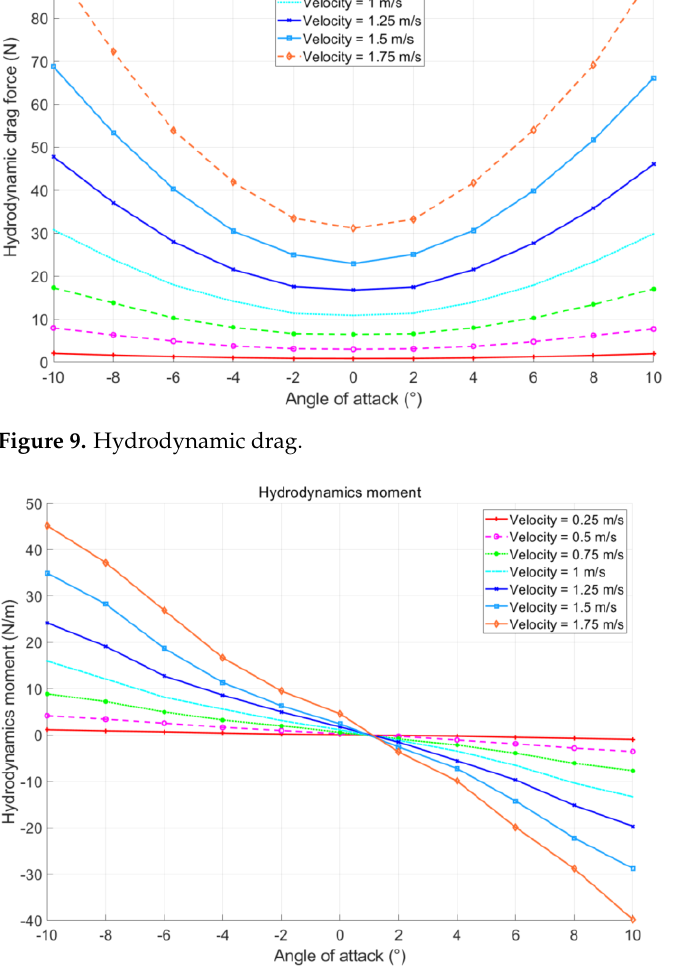
Figure 10. Hydrodynamic moment.